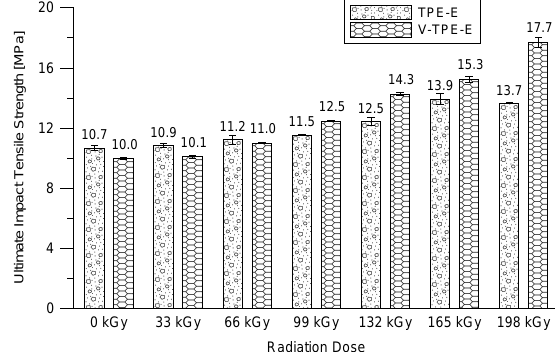
Figure 12. Ultimate impact tensile strength dependence on the radiation dose.